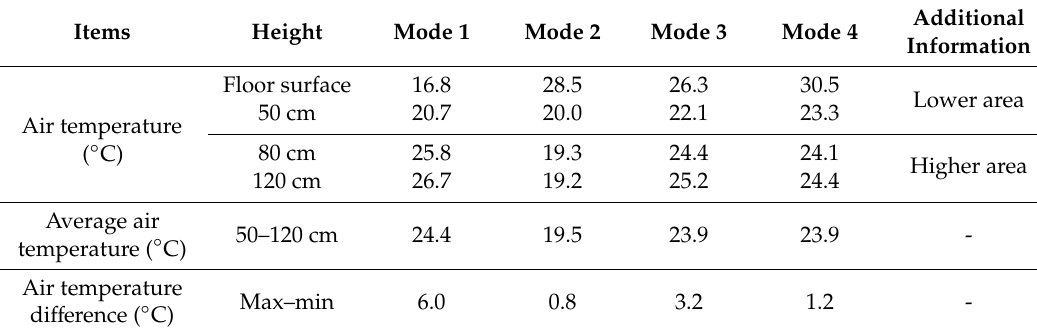
Table 4. Indoor temperature pattern after heating for 90 min. Items